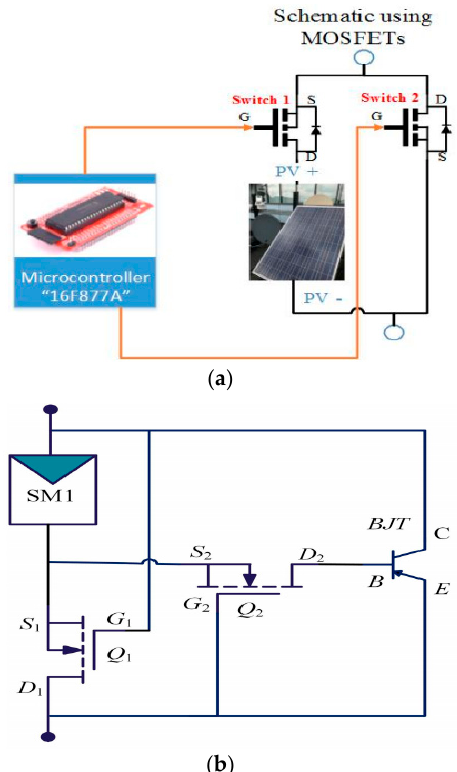
Figure 12. PV hotspot mitigating techniques: ( a ) dual MOSFET concept [32]; ( b ) BJT-based bypass concept [83].